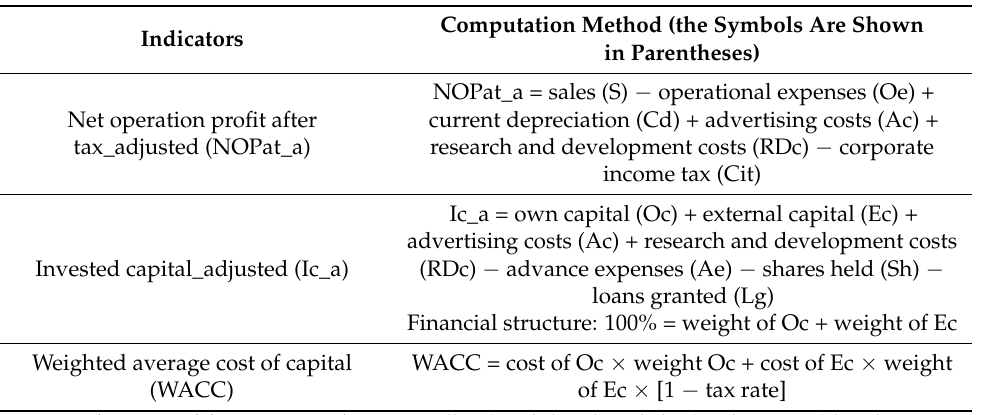
Table 1. Indicators used in analysis. Computation Method (the Symbols Are Shown Indicators in Parentheses) NOPat_a = sales (S) − operational expenses (Oe) + current depreciation (Cd) + advertising costs (Ac) + Net operation profit after research and development costs (RDc) − corporate tax_adjusted (NOPat_a) income tax (Cit) advertising costs (Ac) + research and development costs loans granted (Lg) Financial structure: 100% = weight of Oc + weight of Ec Weighted average cost of